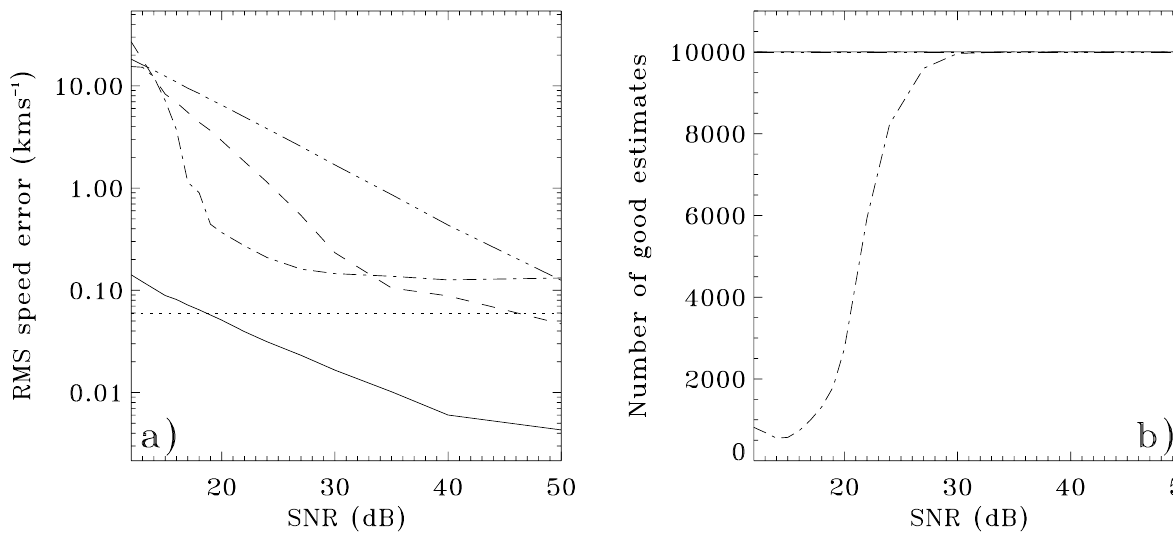
Fig. 3. (a) RMS error in speeds and (b) number of speed estimates obtained using the Fresnel Transform (solid line), spectral (dash-dotted line), pre-t0 (dashed line), and rise-time (dash-triple dotted line) techniques for a 31MHz radar operating at PRF 2kHz and producing an echo with range 150km, meteoroid speed 30km − 1 , and decay time of 0.26s. The dotted line indicates the 0.2% errors for a speed of 30kms − 1 , indicating the expected speed error due to range errors. Note that the number of speed estimates are not shown for the pre-t0 and rise-time techniques since speed estimates were available for all